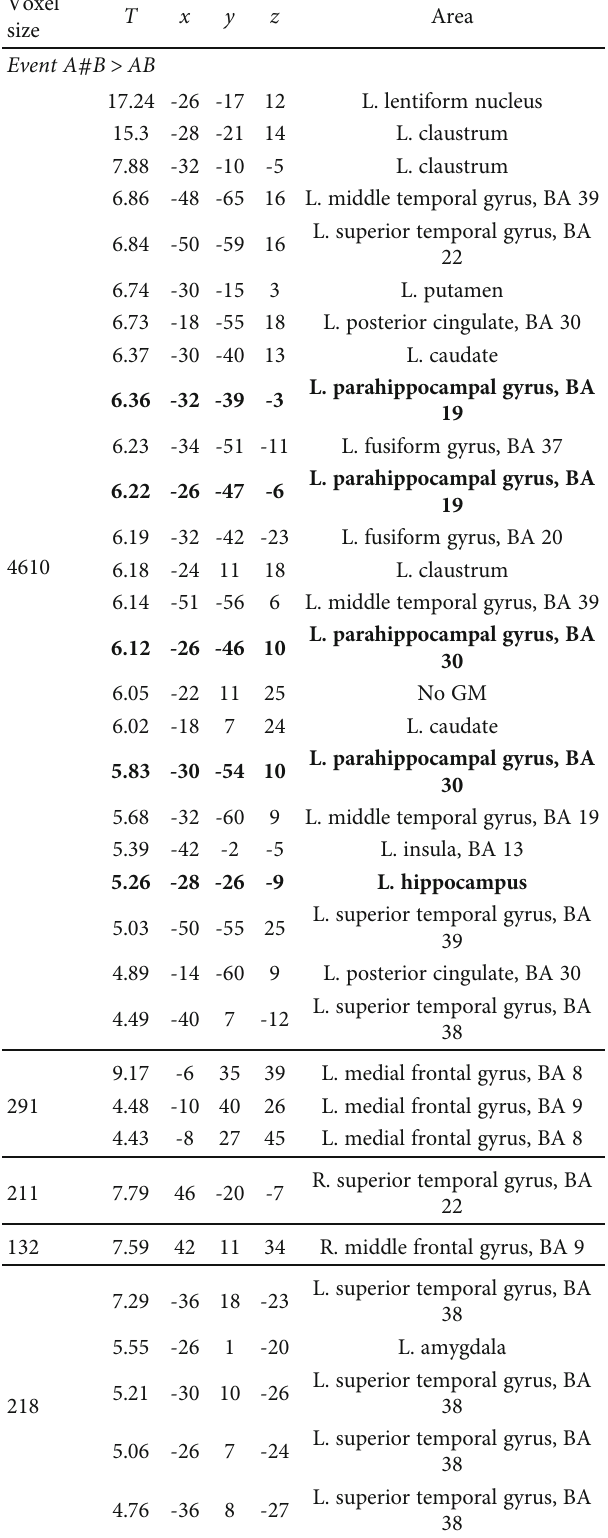
Table 3: Activities shown in the contrast of “ Event A#B > AB ” and “ Event AB > A#B ” .